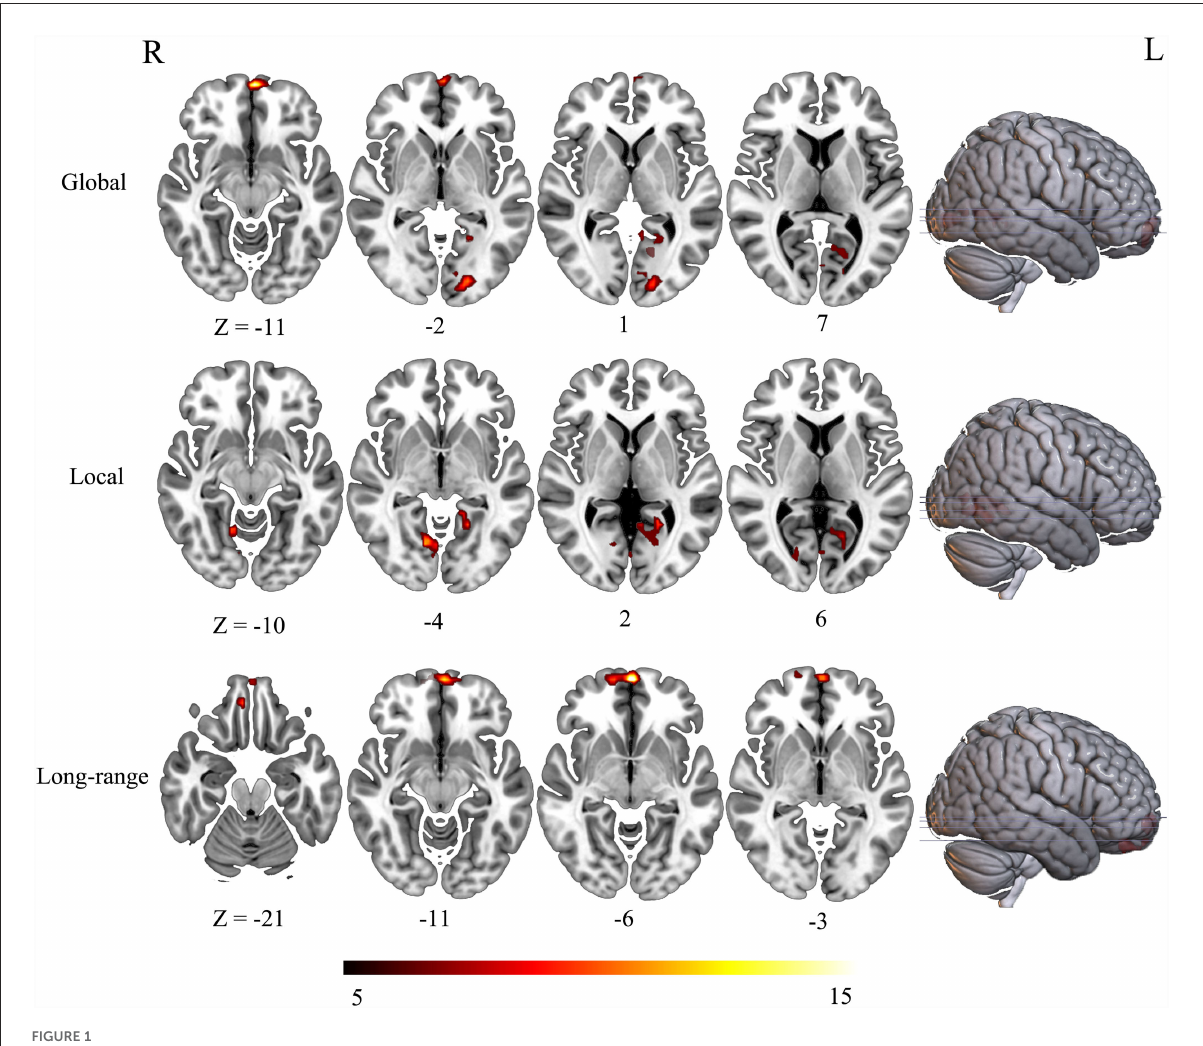
FIGURE1 Altered FCD among the three groups (ANOVA